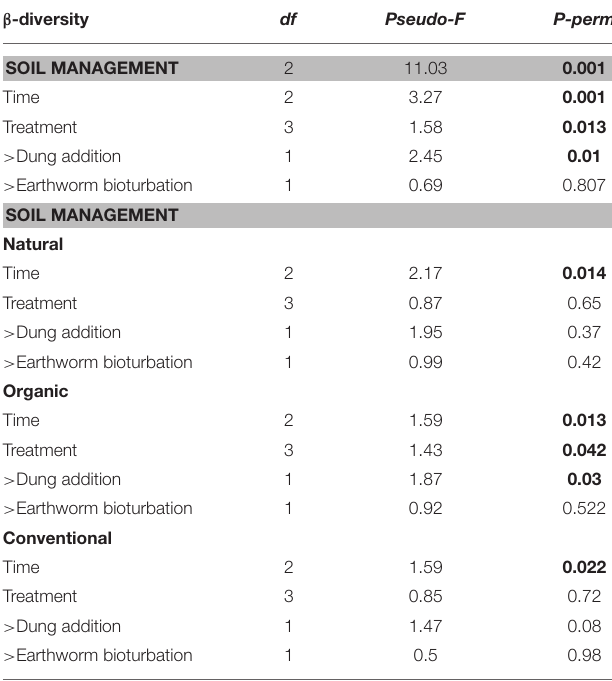
TABLE 3 | Multivariate permutational analyses of variance (PERMANOVA) of β -diversity matrices. β